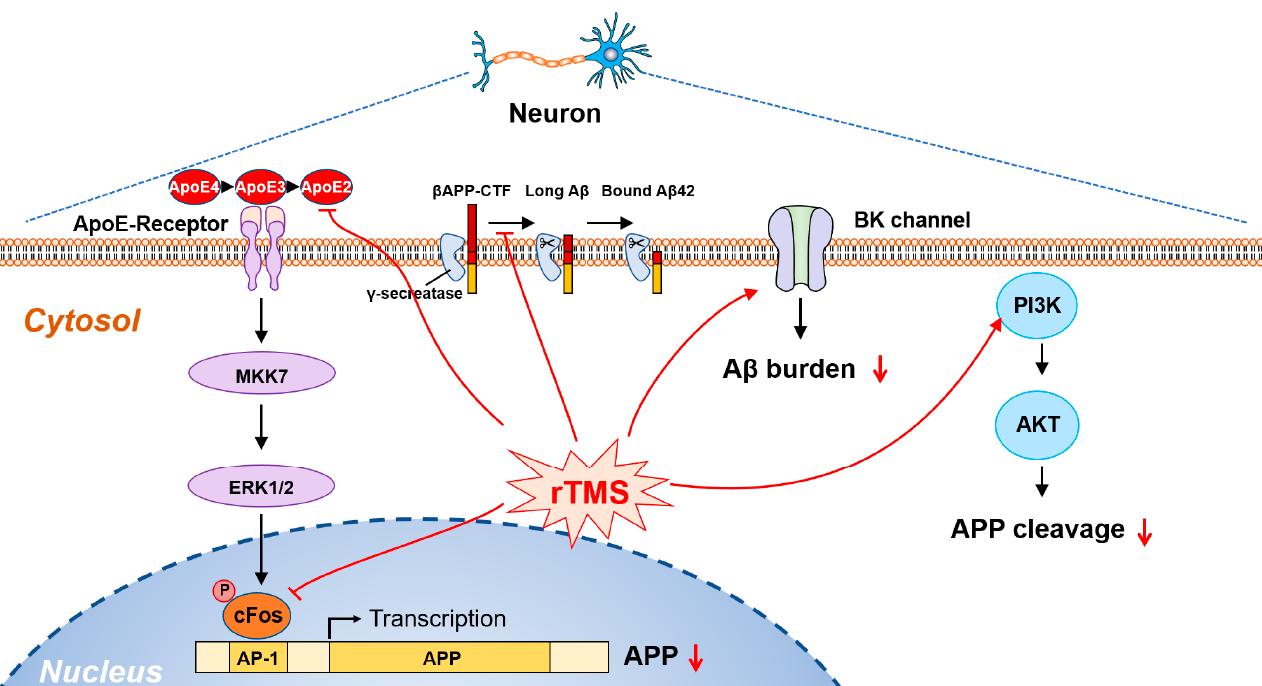
Figure 3. Schematic of signaling pathways responding to the exposure of rTMS in AD. The treatment of rTMS suppresses the transcriptional expression of APP through the inhibition of the MKK7 ‐ ERK1/2 ‐ cFOS axis and facilitates A β clearance by decreasing the expression of ApoE. Moreover, rTMS activates the BK channel and PI3K, resulting in a decrease in the A β burden and APP cleavage, respectively.